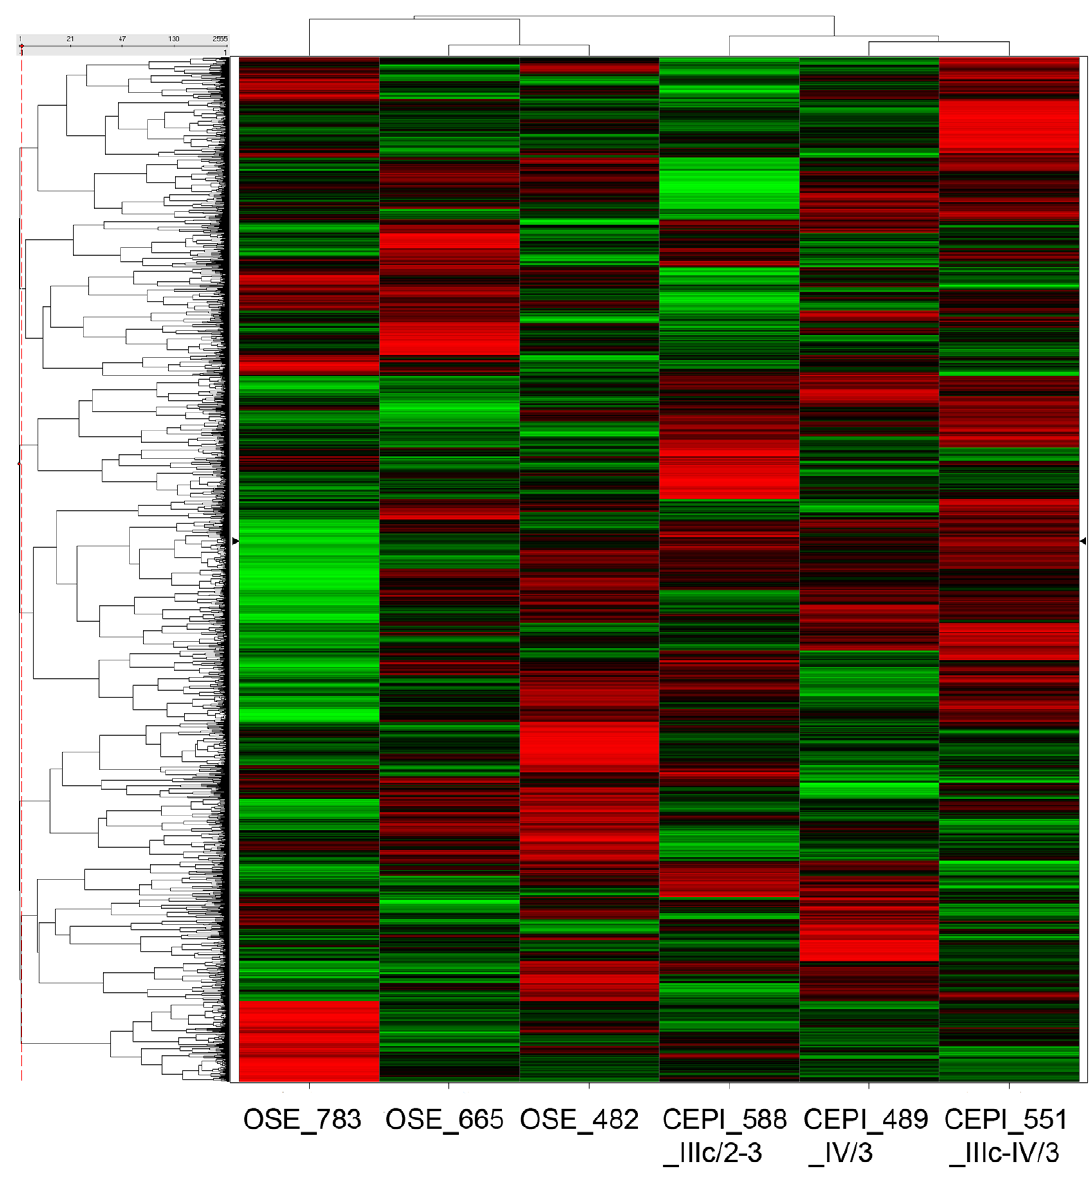
Figure 1. Unsupervised hierarchical clustering of CEPI and OSE samples based on probesets expressed on the Ambion miRChip. An unsupervised hierarchical clustering of the CEPI and OSE samples was carried out using all detected probesets on the Ambion miRChip array, regardless of differential expression. Probesets with standard deviation , 0.5 across all samples were removed prior to clustering. The clustering shows that the CEPI and OSE samples cluster into separate groups, which suggests the variance between the groups is greater than that within the groups.